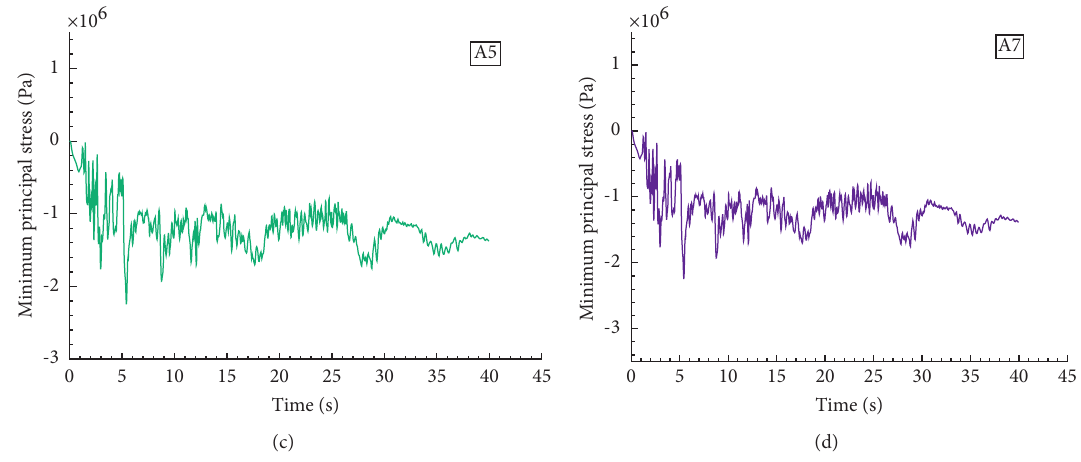
Figure 18: Time history of minimum principal stress